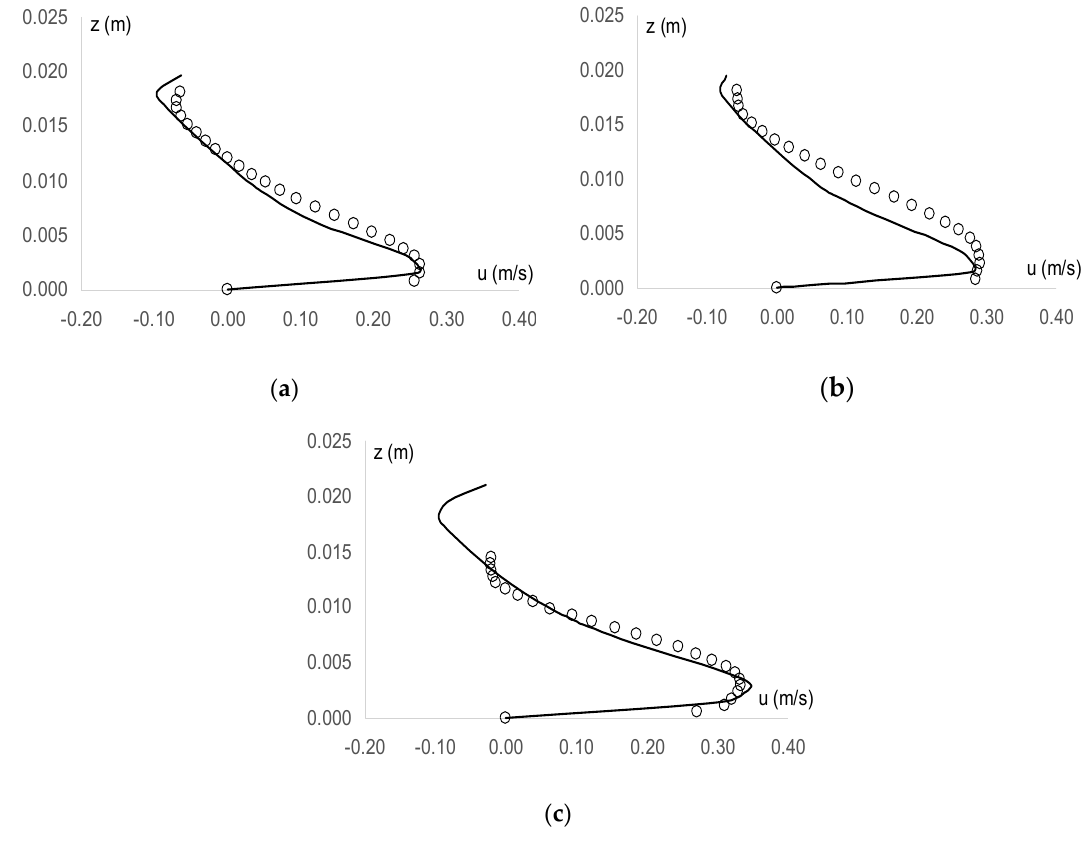
Figure 5. Experimental (open dots) and numerical (continuous line) profiles of local liquid velocities along the vertical lines passing through the center of the recirculation areas that were established inside each cavity for the flow rates per unit width ( a ) 1.11 × 10 − 3 , ( b ) 1.48 × 10 − 3 , and ( c ) 1.85 × 10 − 3 m 3 s − 1 m − 1 . Table 1. Comparisons of experimentally determined and numerically simulated hydraulic features of potential photobiologic significance for the 6 ◦ channel